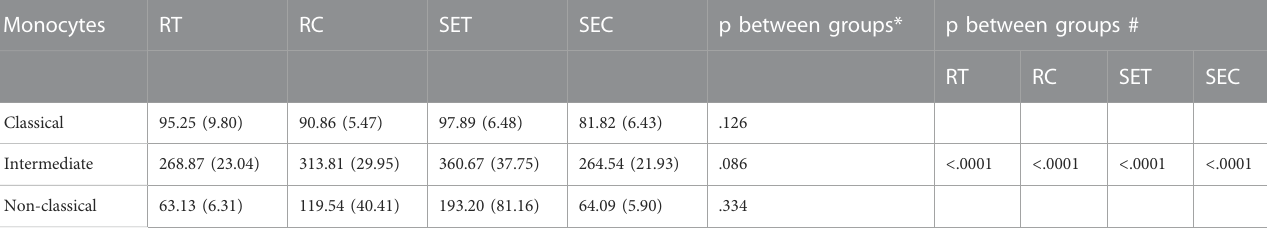
TABLE 10 Level of expression (a.u.) of the receptor CX3CR1 in monocyte subtypes, according to the treatment arms. Monocytes RT RC SET SEC p between groups* p between groups #